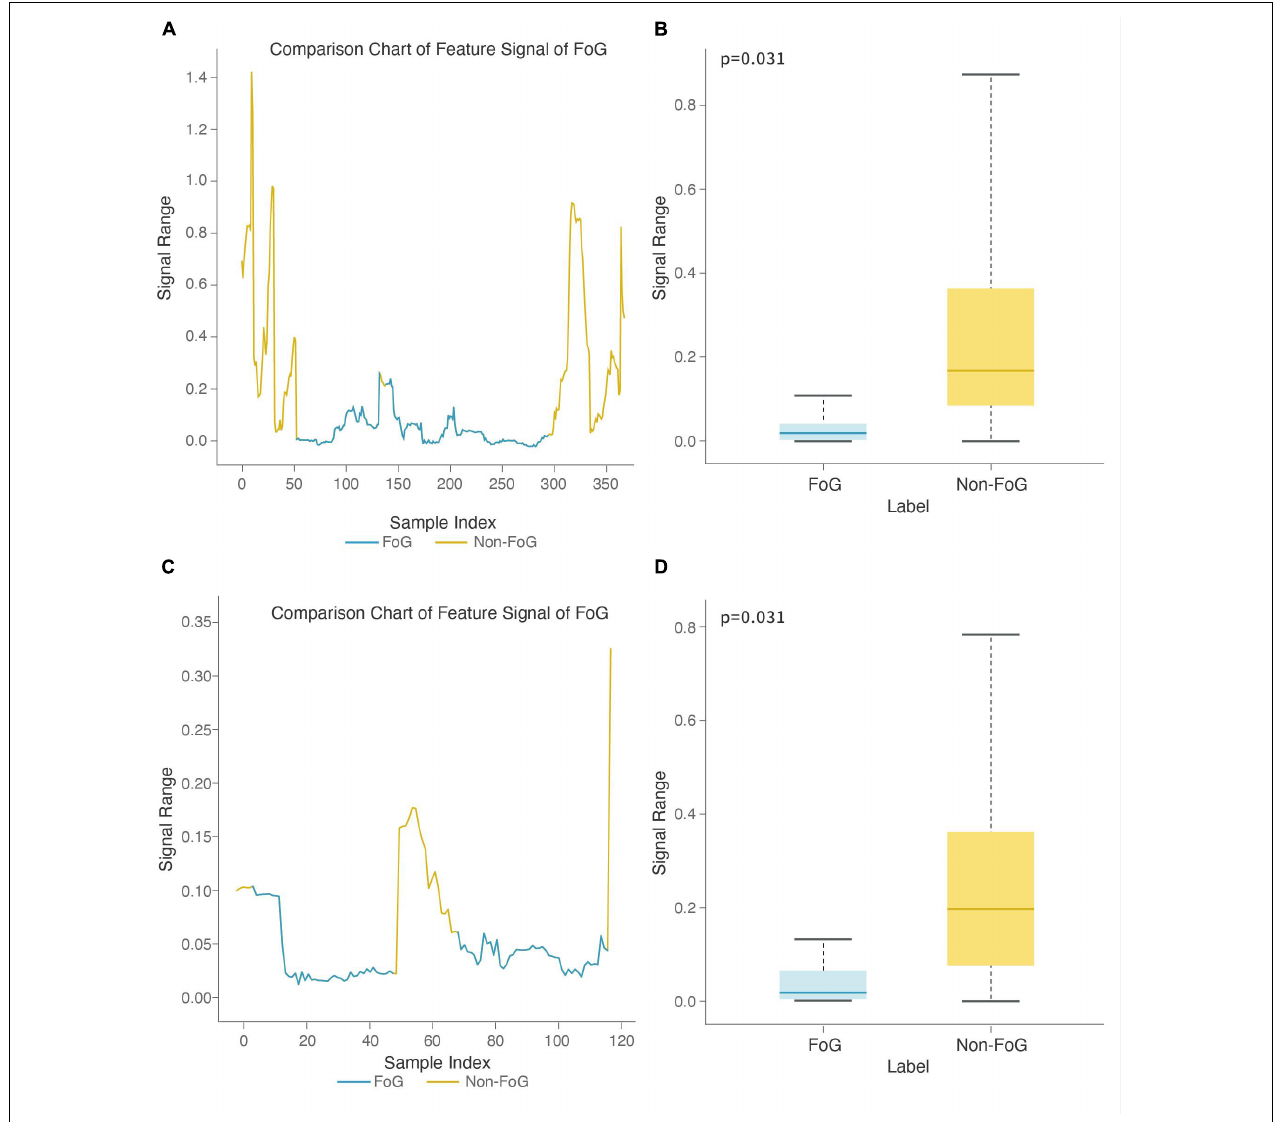
FIGURE 8 | Feature boxplot and stage comparison chart analysis in the turning stage. (A) Stage comparison chart of the area under the power spectrum of the 0.5-3 Hz frequency band calculated by the X -axis acceleration signal from the right heel. (B) Boxplot of the area under the power spectrum of the 0.5-3 Hz frequency band calculated by the X -axis acceleration signal from the right heel. The feature was significantly different between the FOG and non-FOG groups ( p = 0.031). (C) Stage comparison chart of the area under the power spectrum of the 0.5-3 Hz frequency band calculated by the X -axis speed signal form the left heel. (D) Boxplot of the area under the power spectrum of the 0.5-3 Hz frequency band calculated by the X -axis speed signal from the left heel. The feature was significantly different between the FOG and non-FOG groups ( p =